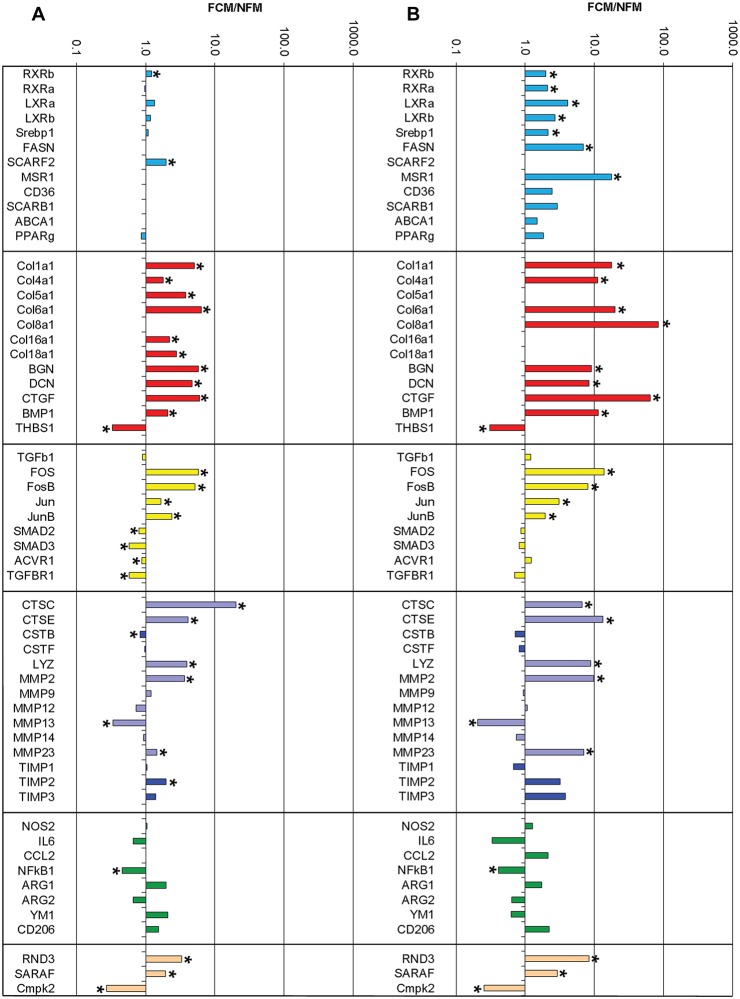
Genes differentially regulated in FCM and NFM.A) array; B) RT-qPCR). Cyan = LXR-related genes, red = extracellular matrix structural proteins, yellow = fibrosis-related signalling and associated molecules, purple/blue = degradative enzymes/inhibitors, green = genes associated with M1 and M2 polarisation, peach = miscellaneous genes. Genes not present on the Illumina chip or not qPCR verified are left blank. *P<0.05.